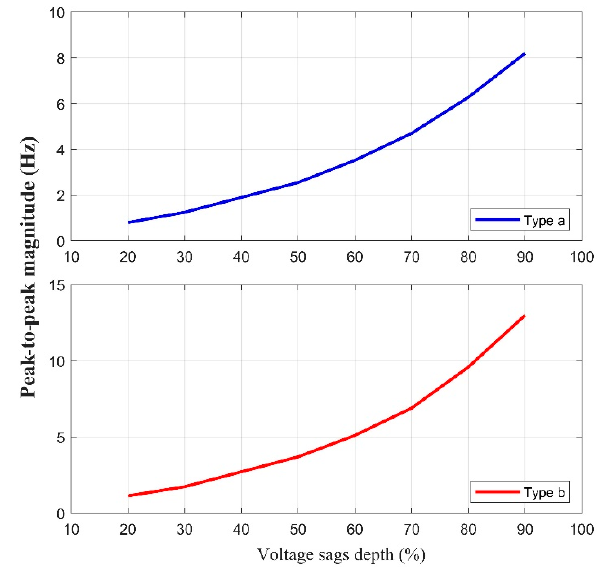
Figure 3. Evolution of the peak-to-peak amplitude of the estimated frequency distortion with the sag depth. Upper: type-a sag. Lower: type-b sag .